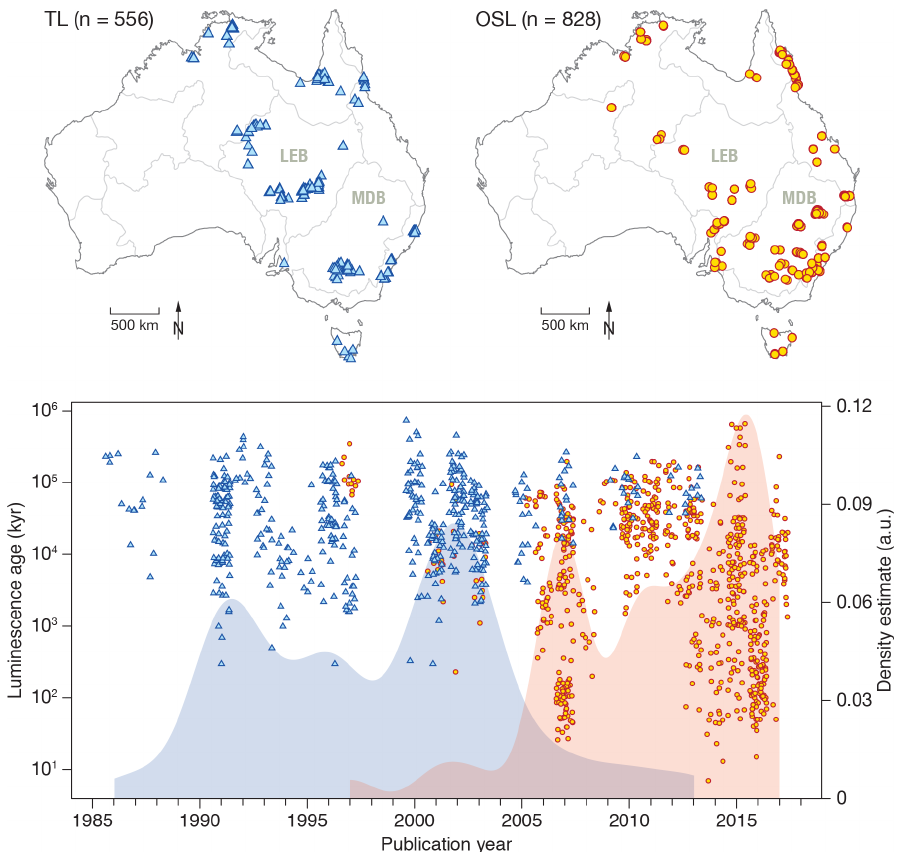
Figure 8. The spatial and temporal extents of the OSL & TL Australia data set. Blue triangles denote TL measurements and yellow circles denote OSL measurements. Grey lines depict major topographic drainage divisions and river regions based on the Australian Hydrological Geospatial Fabric